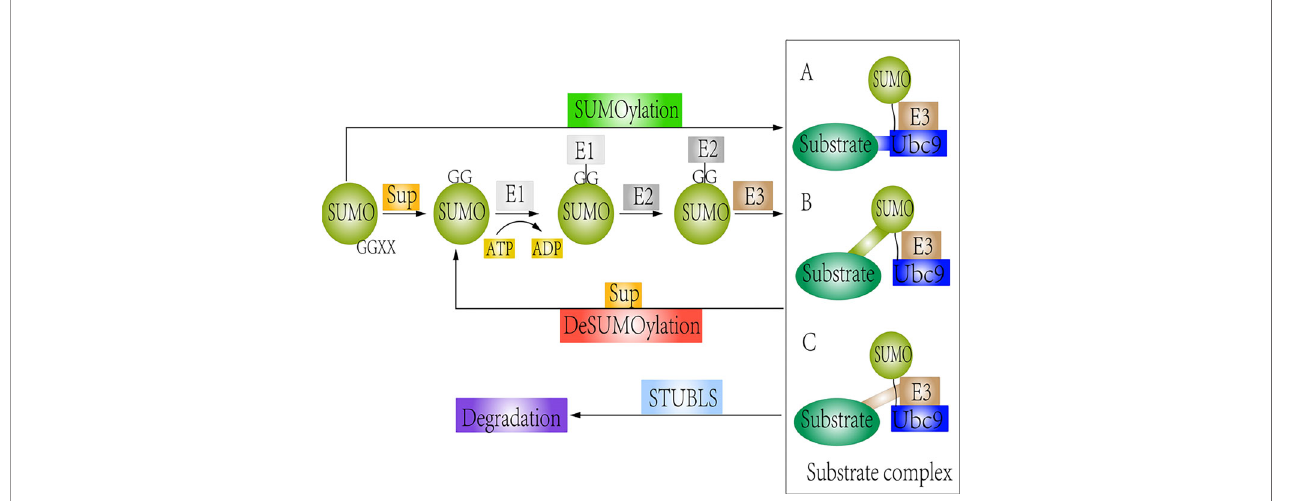
FIGURE 1 | Schematic representation of SUMOylation and deSUMOylation. The fi rst step is maturation of the SUMO protein. Then, mature SUMO is directly activated by SUMO E1 via ATP hydrolysis. Upon interaction of the charged E1 enzyme with E2, SUMO is transferred from E1 to E2. Finally, SUMO links to substrates by different forms: (A) Substrates directly interact with the Ubc9 (SUMO consensus site – directed SUMOylation); (B) Substrates possess the SUMO interaction motif (SIM) (SIM-dependent SUMOylation). (C) Proteins are recognized by a SUMO E3 ligase, which can be accessible to the charged Ubc9 (E3 ligase-dependent SUMOylation). However, SUMO-speci fi c proteases could remove the SUMO protein from the substrate. STUbls promote degradation of SUMOylated